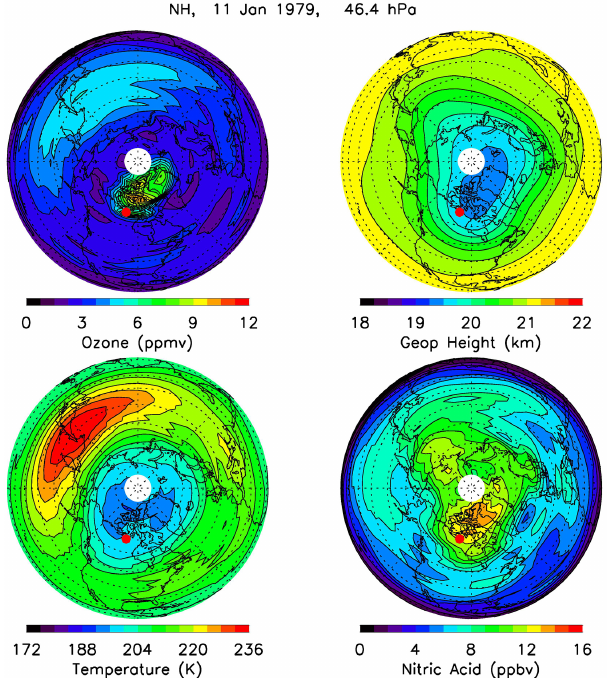
Figure 4. As in Fig. 2 for 11 January, but for the 46.4hPa level; the white plus signs have been removed to give better clarity for the underlying